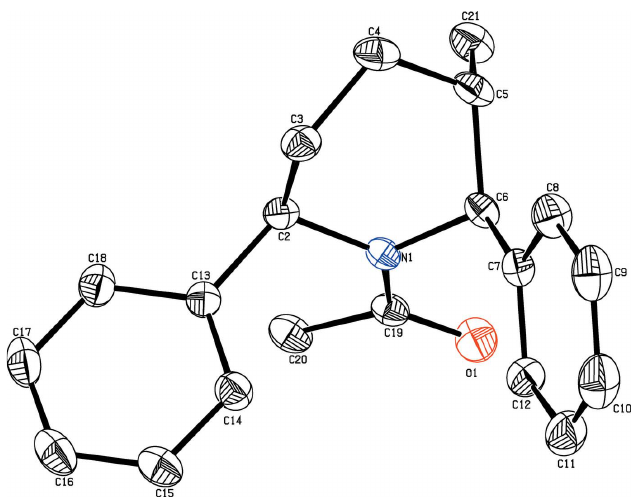
Figure 1 The molecular structure of the title compound, showing the atomic numbering and displacement ellipsoids drawn at the 30% probability level.